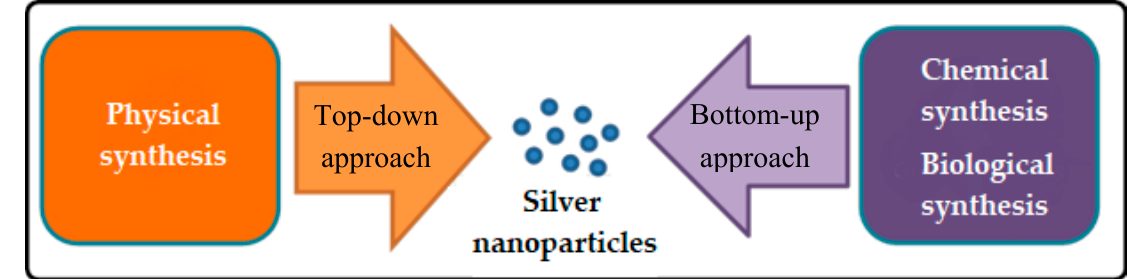
Figure 1. Method of preparing silver nanoparticles.